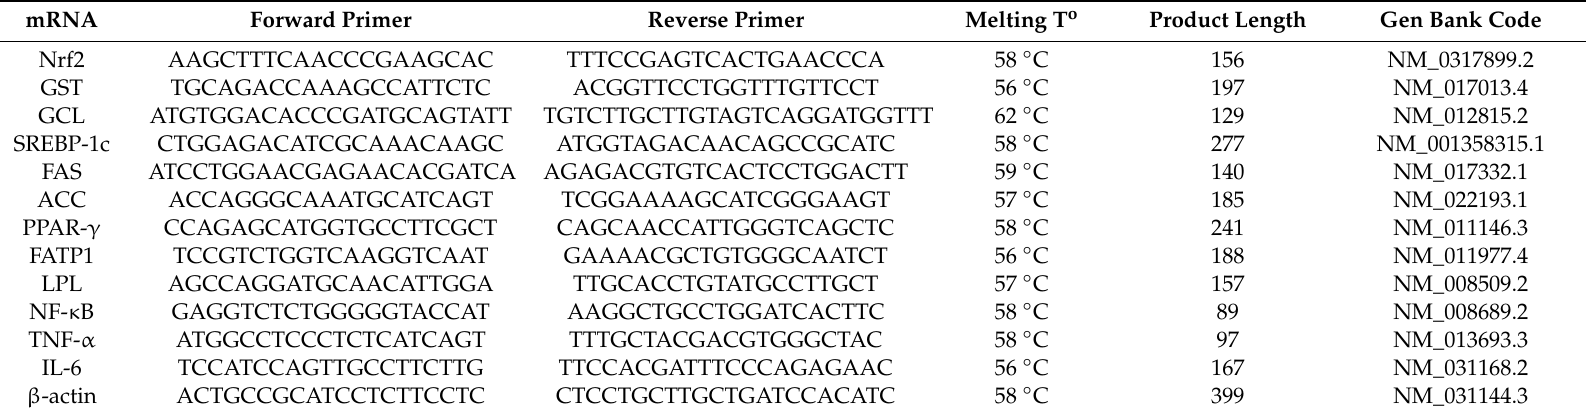
Table 1. Gene-specific primer sequences used in the